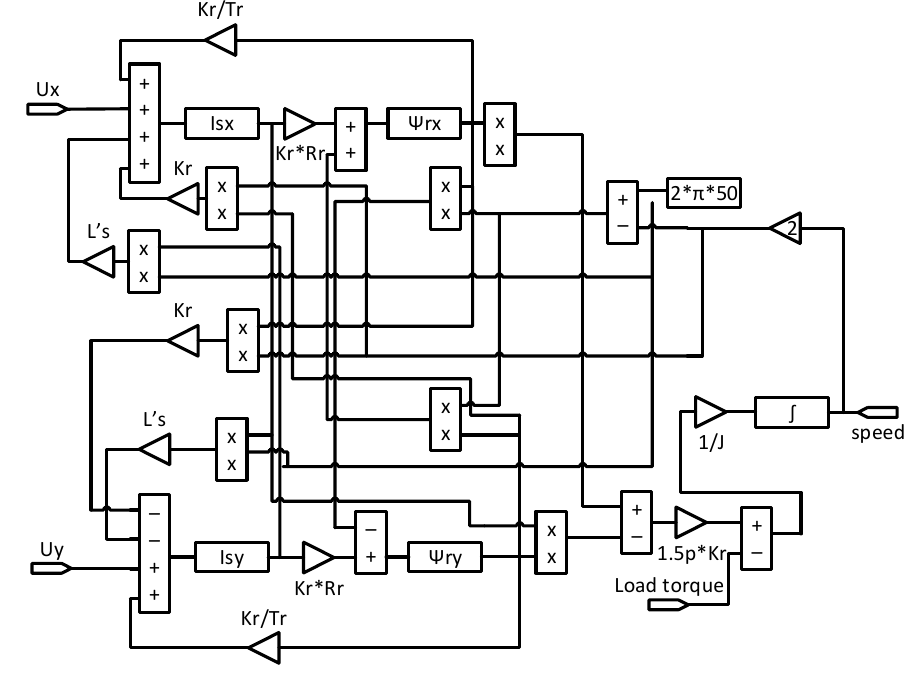
Figure 4. Model of an induction motor.